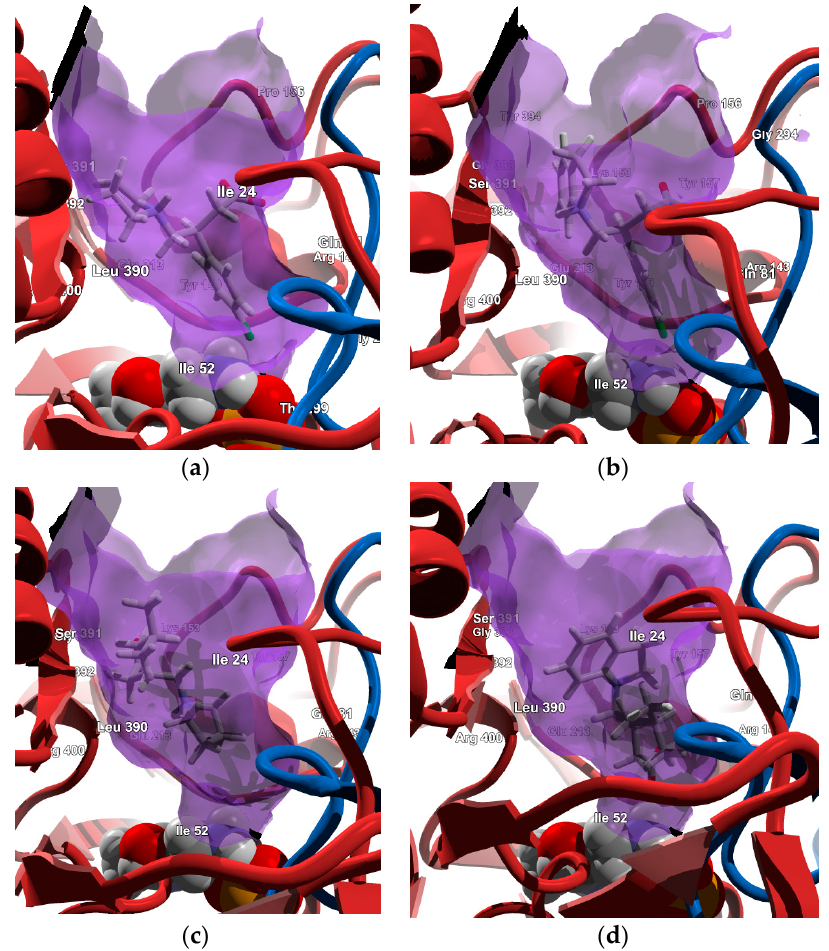
Figure 13. ( a ) ( S )- 19a interaction with Pseudomonas GABA-AT; ( b ) ( S )- 21b interaction with Pseudomonas Figure 13. ( a ) (S) - 19a interaction with Pseudomonas GABA-AT; ( b ) (S) - 21b interaction with GABA-AT; ( c ) ( S )- 18a interaction with Pseudomonas GABA-AT; ( d ) ( S )- 20b interaction with Pseudomonas Pseudomonas GABA-AT; ( c ) (S) - 18a interaction with Pseudomonas GABA-AT; ( d ) (S) - 20b interaction GABA-AT. The PLP prosthetic group is shown as spacefill model. Molecular surface of the interaction with Pseudomonas GABA-AT. The PLP prosthetic group is shown as spacefill model. Molecular between each compound and GABA-AT catalytic site (purple surface of the interaction between each compound and GABA-AT catalytic site (purple color).